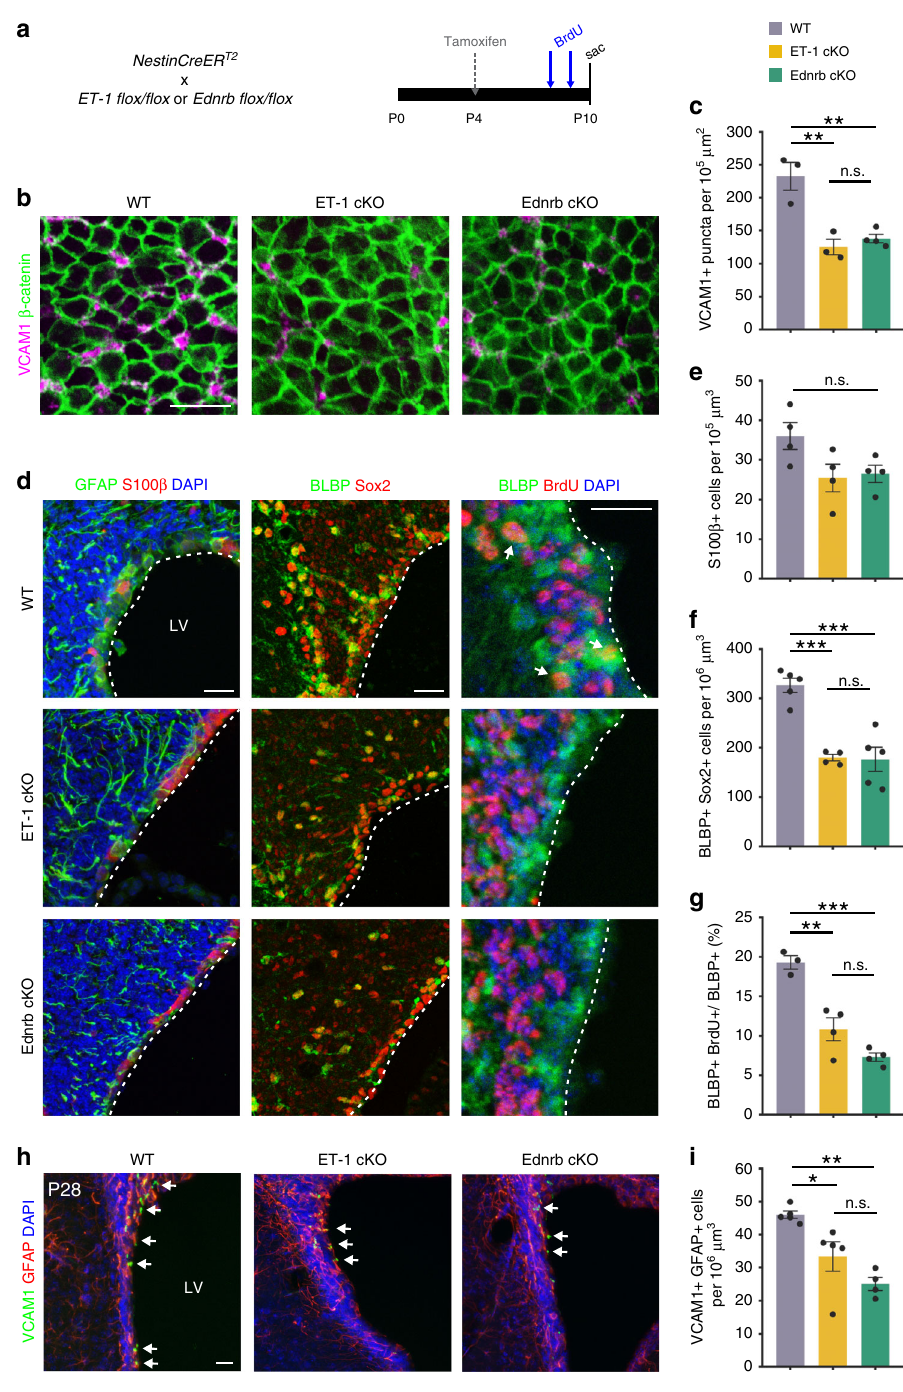
Fig. 2 Ablation of ET-1 or Ednrb reduces radial glial number and proliferation. a Strategy for conditional and inducible ablation of ET-1 or Ednrb in the postnatal SVZ. b Whole mount staining of RGC apical processes in P11 wildtype (WT), ET-1 cKO, and Ednrb cKO SVZ. c Quanti fi cation of the number of VCAM1 + RGCs contacting the apical surface of the SVZ. ( n = 3 WT, 3 ET-1 cKO, 4 Ednrb cKO mice). ** p value = 0.0022 (ET-1 cKO); ** p value = 0.0031 (Ednrb cKO) (one-way ANOVA with Tukey ’ s multiple comparisons test). d Coronal sections of P10 WT, ET-1 cKO, and Ednrb cKO SVZ. e Quanti fi cation of the number of S100 β + cells lining the lateral ventricles at P10. ( n = 4 mice all groups). n.s. not signi fi cant (one-way ANOVA). f Quanti fi cation of the number of BLBP + Sox2 + RGCs in the SVZ at P10. ( n = 5 WT, 4 ET-1 cKO, 5 Ednrb cKO mice). *** p value = 0.0004 (WT versus ET-1 cKO); *** p value = 0.0002 (WT versus Ednrb cKO) (one-way ANOVA with Tukey ’ s multiple comparisons test). g Quanti fi cation of the percentage of proliferating BLBP + radial glia in the SVZ at P10. ( n = 3 WT, 4 ET-1 cKO, 4 Ednrb cKO mice). ** p value = 0.0014; *** p value = 0.0001 (one-way ANOVA with Tukey ’ s multiple comparisons test). h Coronal sections of P28 WT, ET-1 cKO, and Ednrb cKO SVZ. Arrows point to VCAM1 + GFAP + neural stem cells. i Quanti fi cation of the total number of VCAM1 + GFAP + neural stem cells in the dorsal SVZ at P28. ( n = 5 WT, 5 ET-1 cKO, 4 Ednrb cKO mice). * p value = 0.0266; ** p value = 0.0015 (one-way ANOVA with Tukey ’ s multiple comparisons test). All scale bars = 25 μ m. LV lateral ventricle. Data are presented as mean values ± SEM. Source data are provided as a Source Data fi